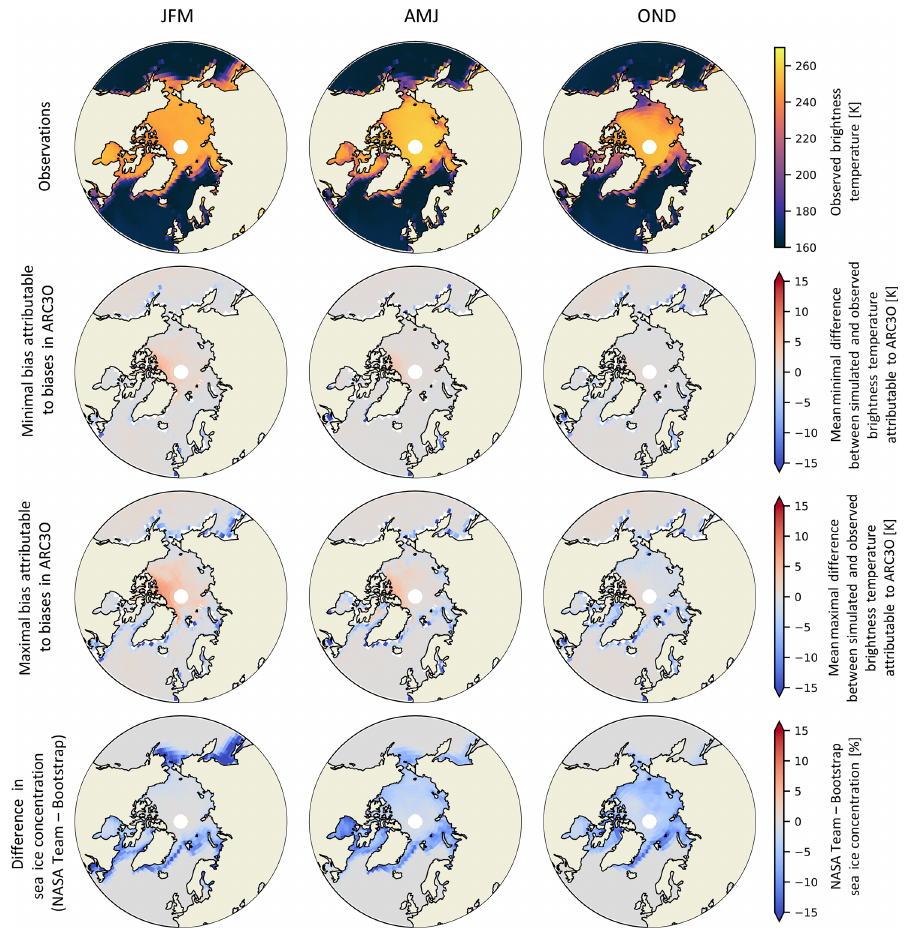
Figure 8. Observed brightness temperatures (first row), mean minimal (second row) and mean maximal (third row) estimates of (cid:49) ARC3O , and differences in sea ice concentration (fourth row) between the NASA Team and Bootstrap assimilation runs, i.e., maximal estimates of (cid:49) retriev